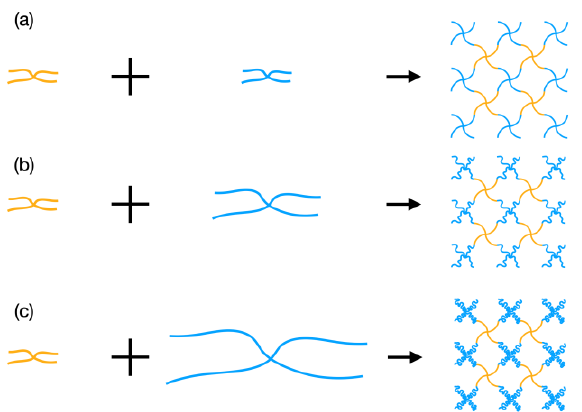
Figure 1. Schematic illustration of the design of the tetra-poly (acrylic acid)-poly (ethylene glycol) gels (Tetra-PAA-PEG gels) with tuned neutral segment lengths, where the orange and blue parts represent the poly (acrylic acid) and poly (ethylene glycol) units, respectively. ( a ) 10 K Tetra-PAA-PEG gel; ( b ) 20 K Tetra-PAA-PEG gel; and ( c ) 40 K Tetra-PAA-PEG gel.